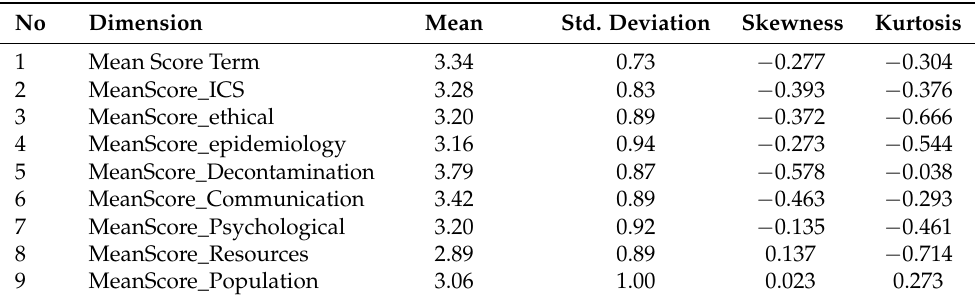
Table 1. The means, standard deviations, and ranges scores of preparedness in managing COVID-19 pandemic among the nurses ( n = 317). No Dimension Std. Deviation